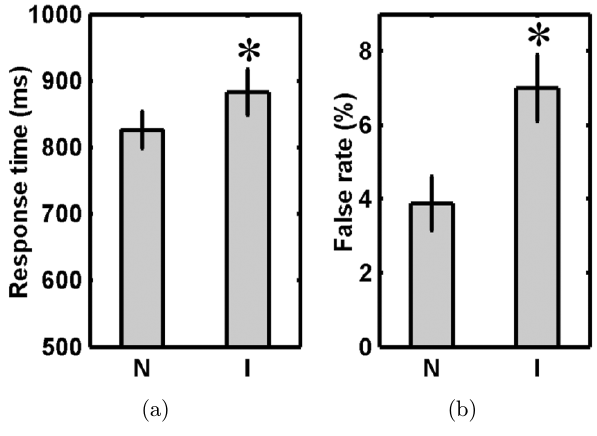
Fig. 2. Grand average response time (a) and false rate (b) for each stimulus condition. Data are shown in mean (cid:1) standard error (SE). N, neutral stimulus; I, Incongruent stimulus. Black asterisk indicates signi¯cant